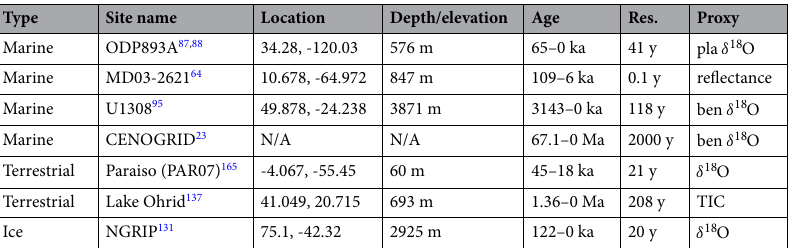
Table 1. Records analyzed using the augmented KS test 19 , ordered by geological type and temporal scale; the nature of the records is indicated in the last column by the abbreviations ben = benthic, pla = planktonic, and TIC = Total Inorganic